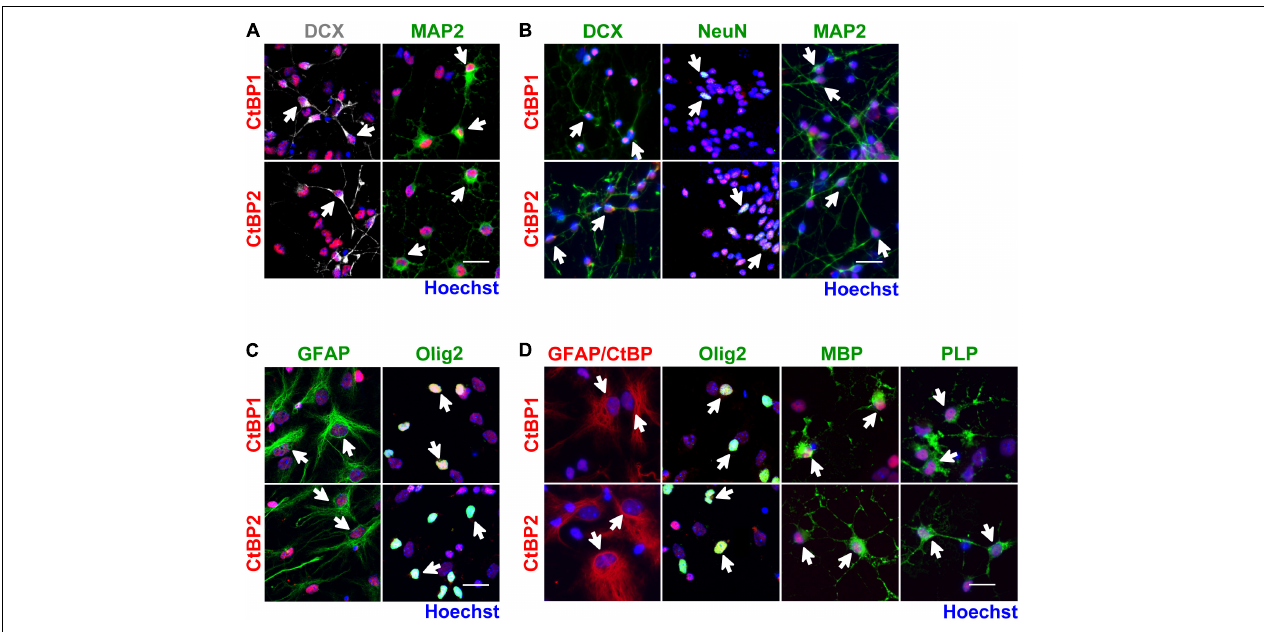
FIGURE 2 | CtBP1 and CtBP2 are expressed in neurons and glia derived from SVZ NSCs. (A,B) Representative confocal images of the expression of CtBPs in neuroblasts (DCX) and neurons (MAP2 or NeuN), evaluated (A) 48 h and (B) 7 days after 6-day-old neurospheres have been seeded in coverslips. (C,D) Representative confocal images of the expression of CtBPs in (C) astrocyte-like cells (GFAP) and in oligodendrocytes/type C cells (Olig2), evaluated 48 h after 6-day-old neurospheres have been seeded in coverslips and in (D) astrocytes (GFAP) and oligodendrocytes (Olig2, MBP, and PLP), evaluated 7 days after the seeding of neurospheres. Nuclei are shown in blue (Hoechst staining). White arrows highlight cells with double staining. Scale bar: 20 µ m.